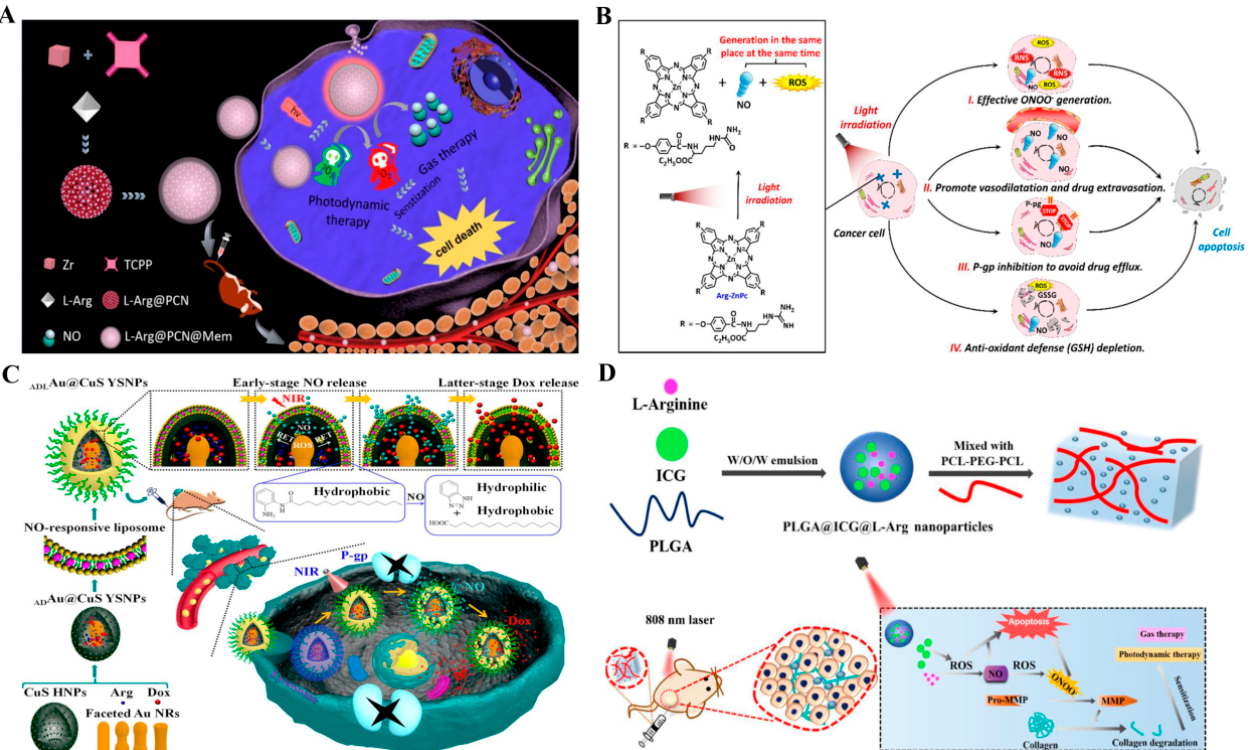
Figure 4. ( A ) Schematic diagram of the preparation of the L-Arg@PCN@Mem and the tumor-killing mechanism. Reproduced with permission from [83], Biomaterials, 2018; ( B ) mechanism diagram of cancer cells apoptosis facilitated by the integration of various functions within L-arginine ethyl ester-modified zinc phthalocyanine (Arg–ZnPc). Reproduced with permission from [84], Molecular Pharmaceutics, 2020; ( C ) schematic diagram of the preparation of L-arginine/Dox-loaded gold@copper sulfide yolk − shell nanoparticles (ADLAu@CuS YSNPs), the mechanism diagram of the process of NO and DOX being sequentially released plays an anti-tumor effect under NIR irradiation in cancer cells. Reproduced with permission from [85], Nano Letters, 2019; ( D ) schematic diagram of the preparation of PLGA@ICG@L-Arg nanoparticles and the process of anti-tumor effects under NIR irradiation in cancer cells. Reproduced with permission from [86], Molecular Pharmaceutics, 2021.